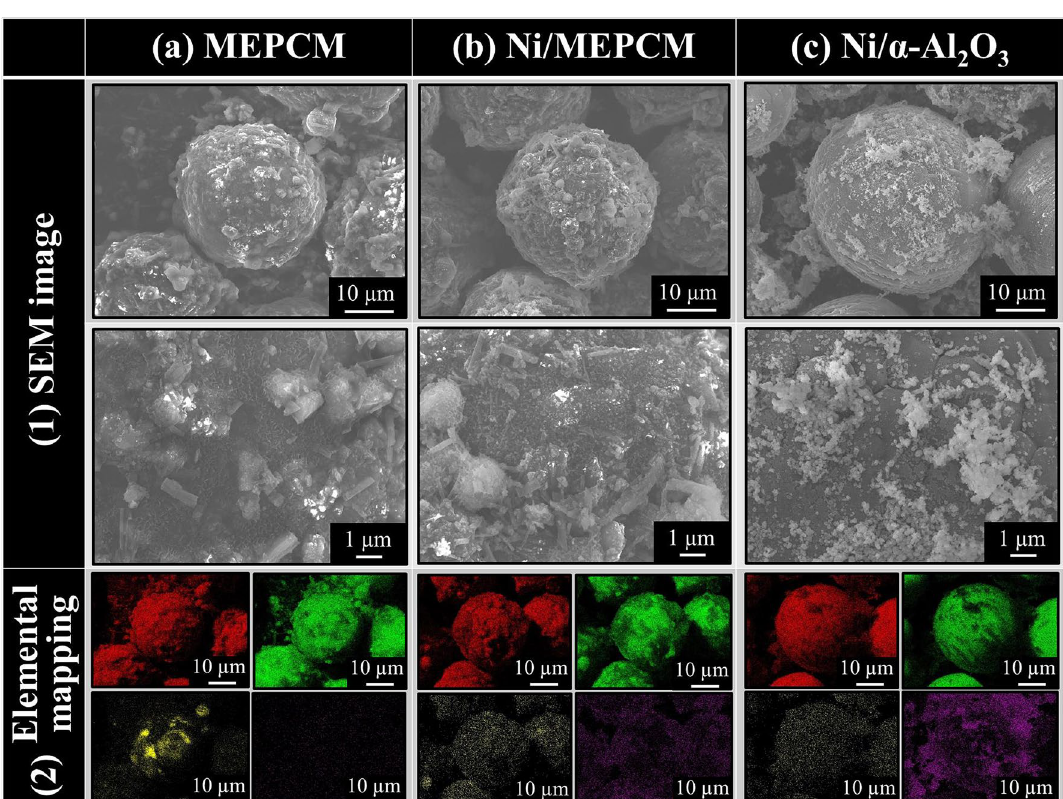
Figure 5. Scanning electron microscopy (SEM) image and the Energy dispersive spectroscopy (EDS) elemental mapping of the ( a ) MEPCM, ( b ) Ni/MEPCM, and ( c ) Ni/α-Al 2 O 3 . In the elemental mapping, the red area represents O, the green area represents Al, the yellow area represents Si and the purple area represents